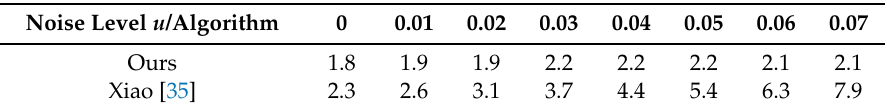
Figure 8. Detailed 3D reconstruction result comparison with bundle adjustment [35]. ( a , b ) Details of the 3D model from [35]; ( c , d ) details of the 3D model from the proposed method. Table 2. Robust comparison using artificial noise. We compare the trajectory results from our methods and Xiao et al. [35] when increasing the artificial